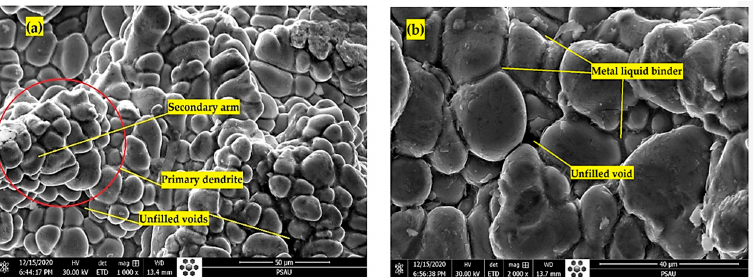
Figure 10. SEM micrographs of crack face of TIG weld specimen coated with Nb powder ( a ) (×1000) and ( b ) (×2000).